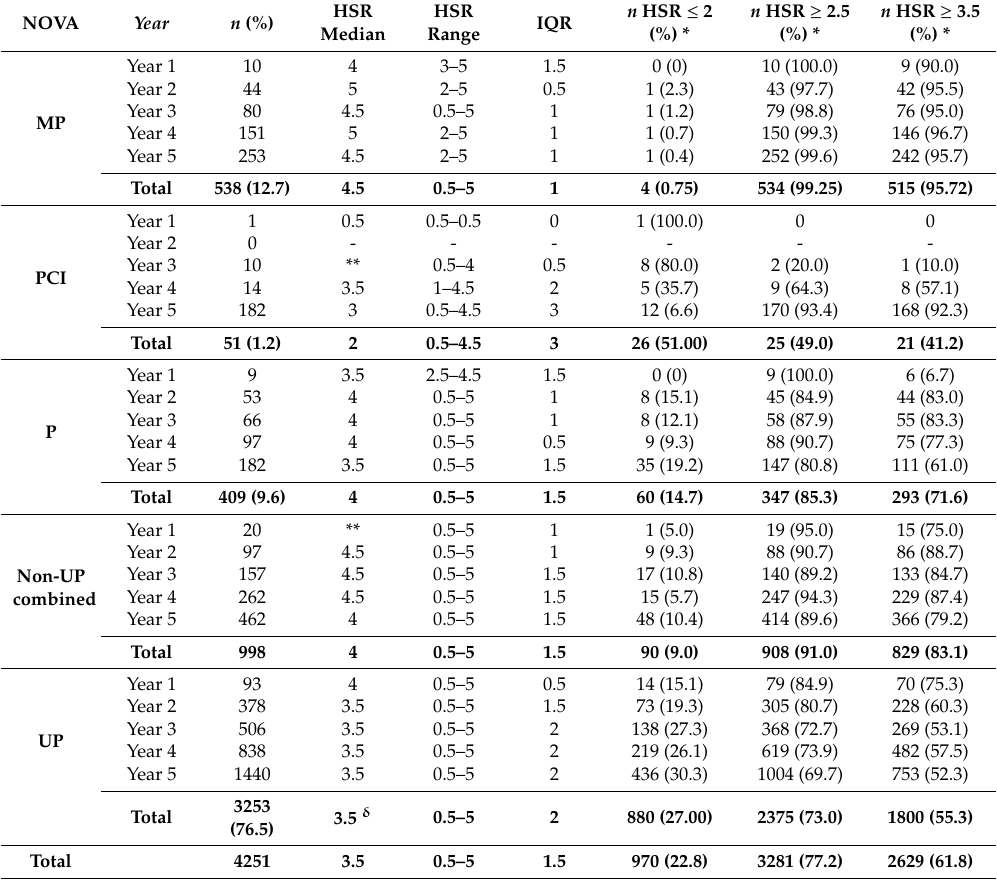
Table 2. Descriptive statistics of HSR by NOVA category and implementation year.